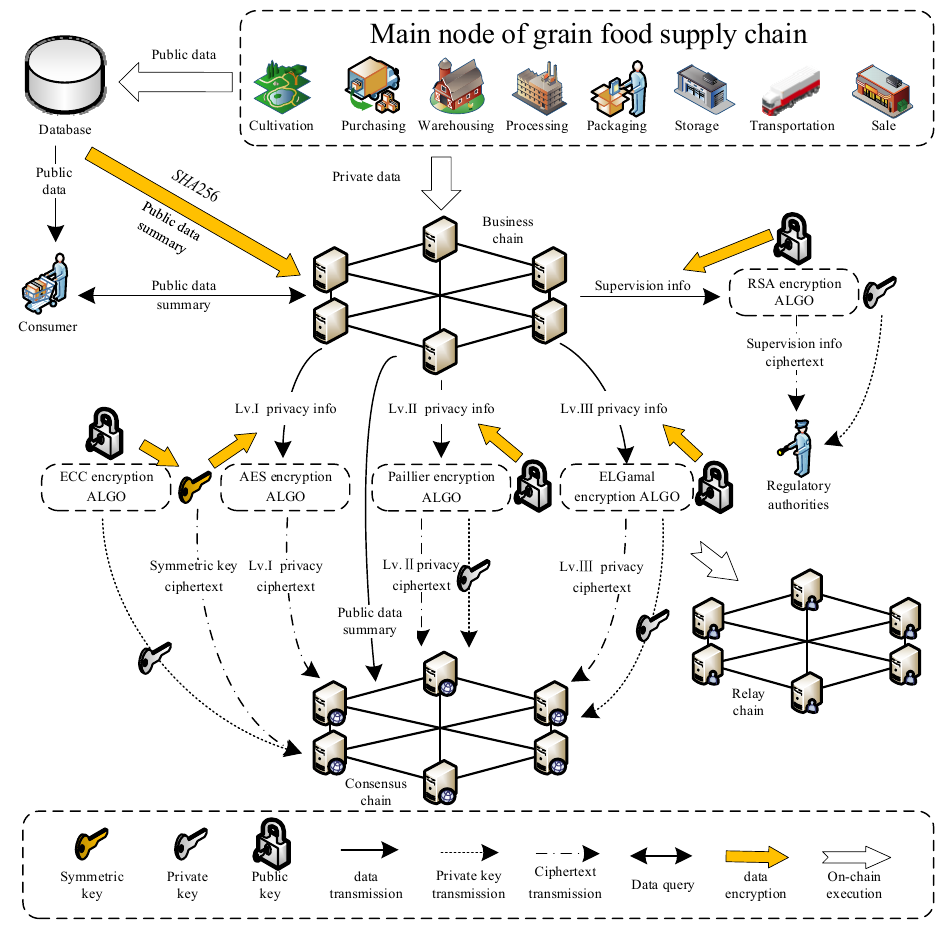
Figure 3. Hierarchical encryption and storage mode of private data.